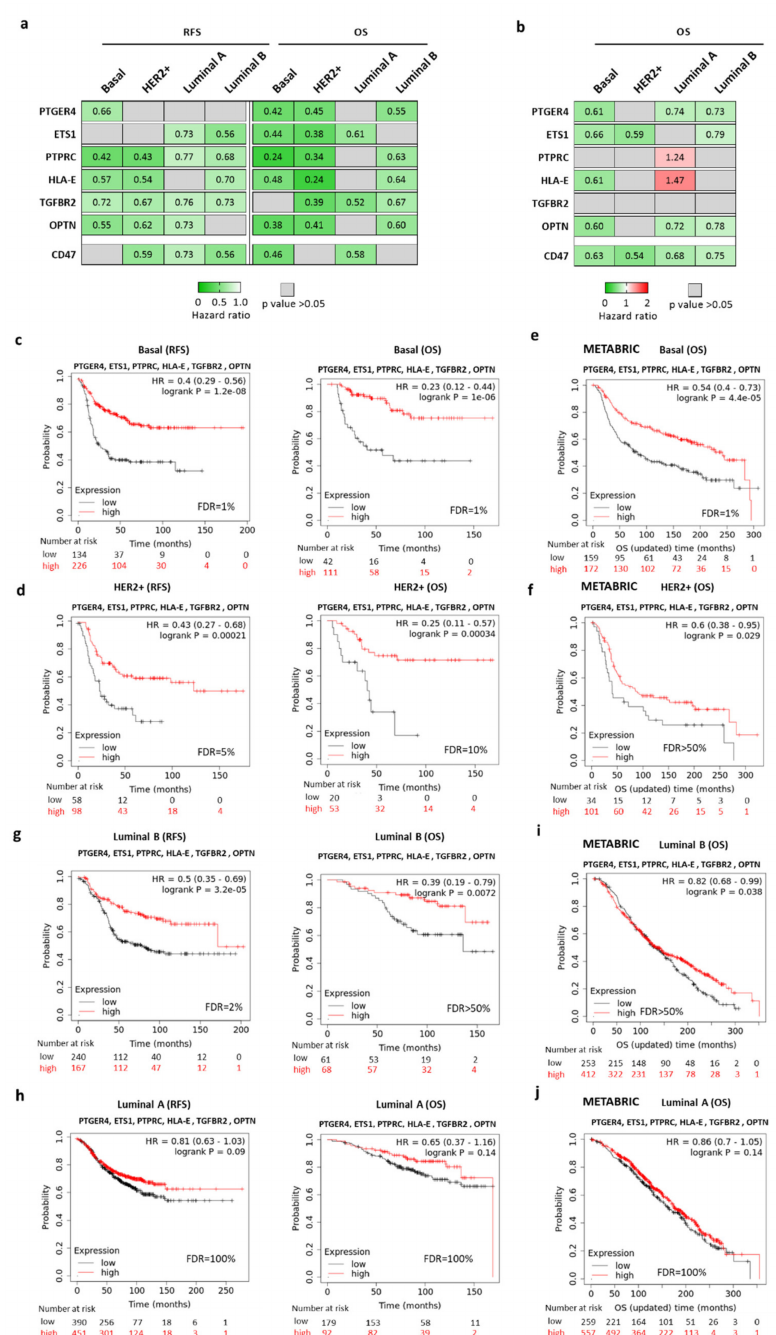
Figure 2. Kaplan–Meier survival curves of the association between transcriptomic expression of PTGER4, ETS1, PTPRC, HLA-E, TGFBR2, and OPTN and clinical outcome in basal-like, HER2+, luminal A, and luminal B breast cancer patients. ( a , b ) Heat map displaying HR values extracted from Kaplan–Meier survival plots for the association between PTGER4, ETS1, PTPRC, HLA-E, TGFBR2, OPTN, and CD47 individually expression levels and patient prognosis, in the exploratory cohort and Molecular Taxonomy of Breast Cancer International Consortium (METABRIC) validation cohort, respectively. ( c , d ) basal-like (relapse-free survival (RFS); n = 360 and OS; n = 153), and HER2+ (RFS; n = 156 and OS; n = 53), breast tumors in the exploratory cohort. ( e , f ) basal-like (OS; n = 331) and HER2+ (OS; n = 135) in the validation cohort (METABIRC project). ( g , h ) luminal B (RFS; n = 841 and OS; n = 271), and luminal A (RFS; n = 407 and OS; n = 129) in the exploratory cohort. ( i , j ) luminal B (OS; n = 816), and luminal A (OS; n = 665) breast tumors in the validation cohort (METABIRC